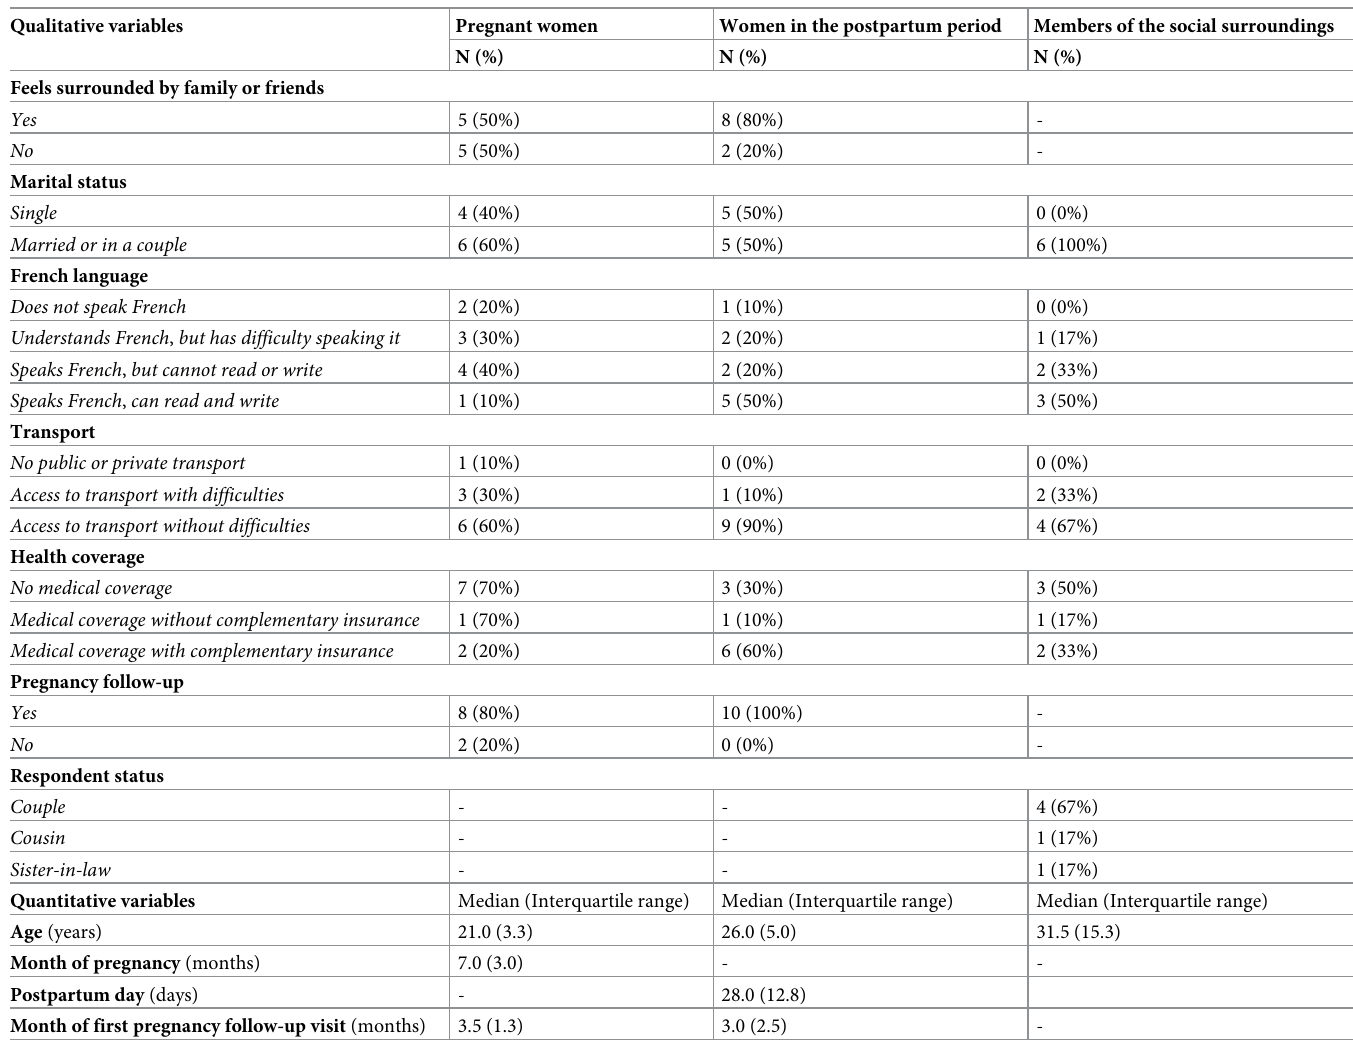
Table 3. Socio-demographic characteristics of the study